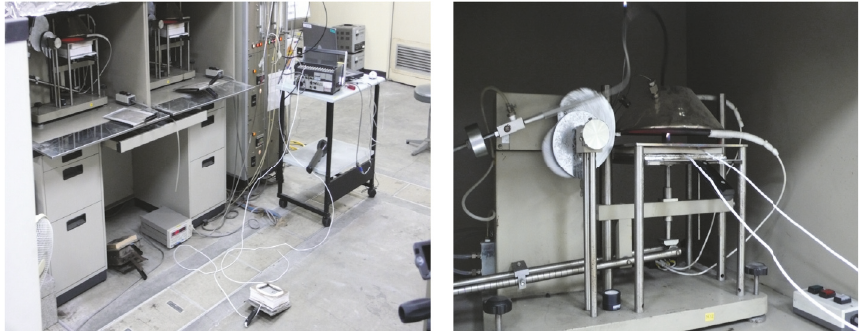
Figure 1: Flammability test and temperature measurement test.